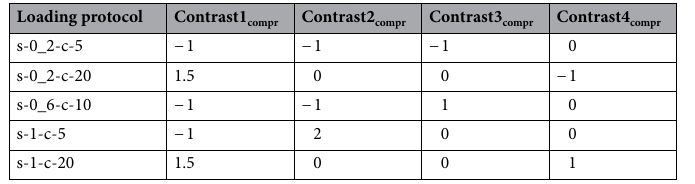
Table 4. Contrasts and their respective weights for the loading protocols—split first according to compression. s shear frequency, c compressive strain.